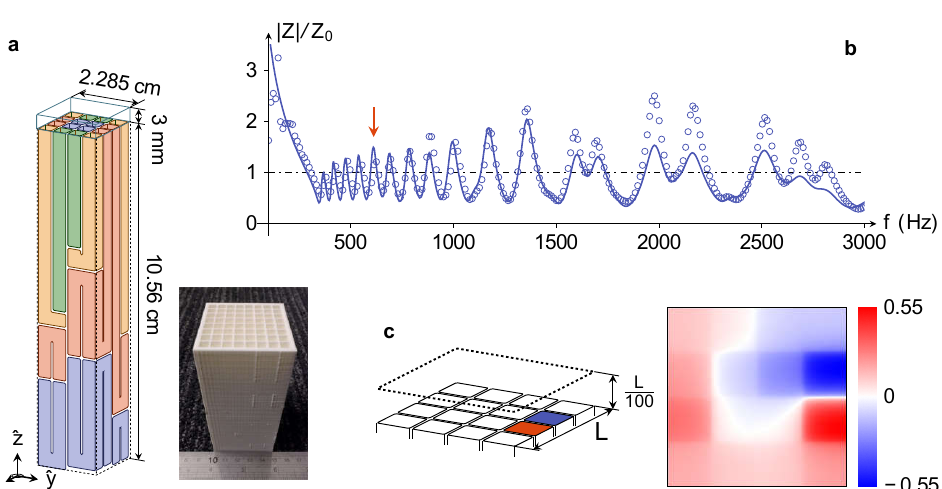
Figure 3. Metamaterial unit and its features. ( a ) Schematics of the metamaterial unit consisting of 16 Fabry-Perot (FP) channels, arrayed in a 4 × 4 square lattice. A photo image of a sample comprising 4 units arranged in a mirror-symmetric pattern is shown in the lower left panel. ( b ) The surface impedance of the metamaterial unit plotted as functions of frequency. The circles are deduced from the measured reflection coefficient while the curves are the theory predictions. The arrow denotes the frequency at which the simulations were carried out on the sound pressure field, shown in the right panel below. ( c ) Right panel: The simulated sound pressure field at 0.22 mm above the front surface of the metamaterial unit at 612 Hz, which is the anti-resonance frequency between the FP resonances of the 5th and 6th channels (blue and red squares), shown in the left panel. The color is indicative of the pressure amplitude normalized to that of the incident wave. At anti-resonance, there is no coupling to the propagating modes; only an evanescent mode exists as explained in the text.